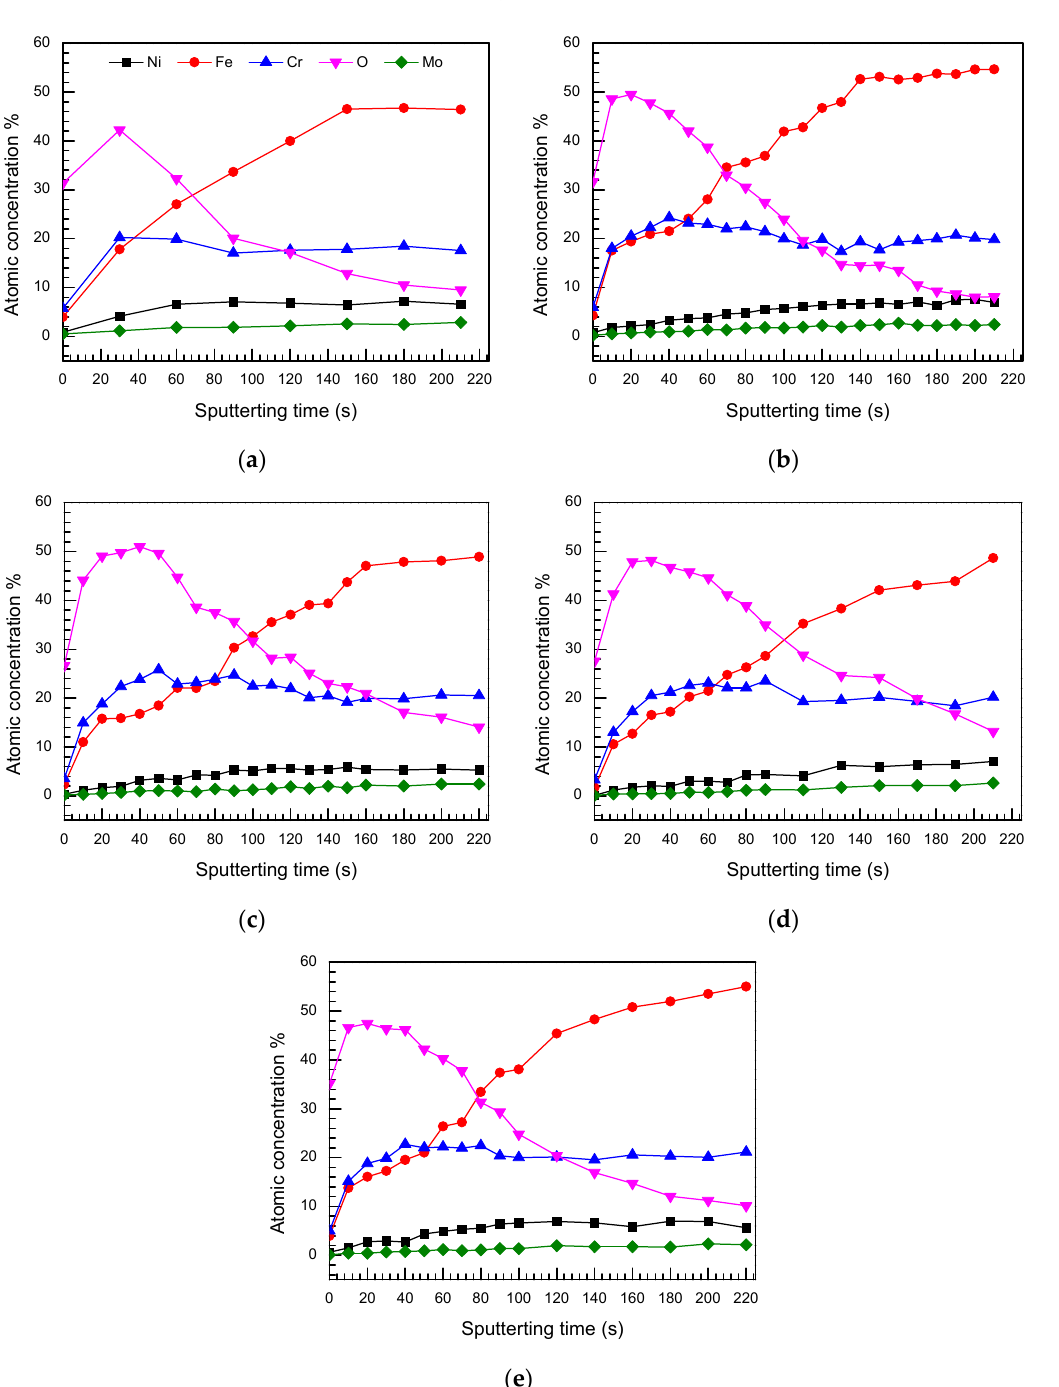
of XPS depth profiles based on peak areas revealed the element content of passivation films from surface to substrate (Figure 7).